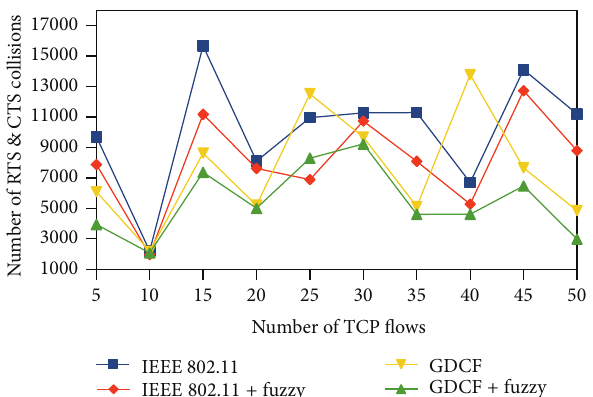
Figure 17: Number of RTS, CTS collisions for 1000∗1000 scenario.